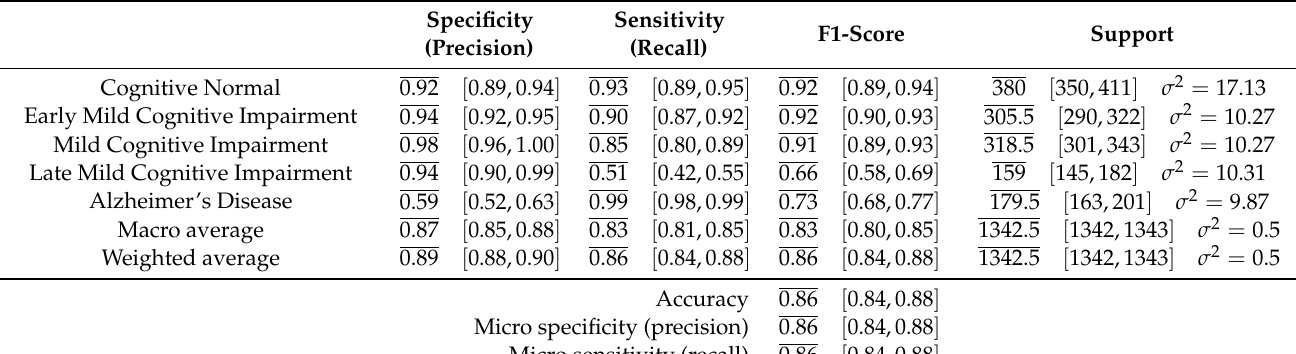
Table 2. Evaluation metrics of the obtained DNN at 110